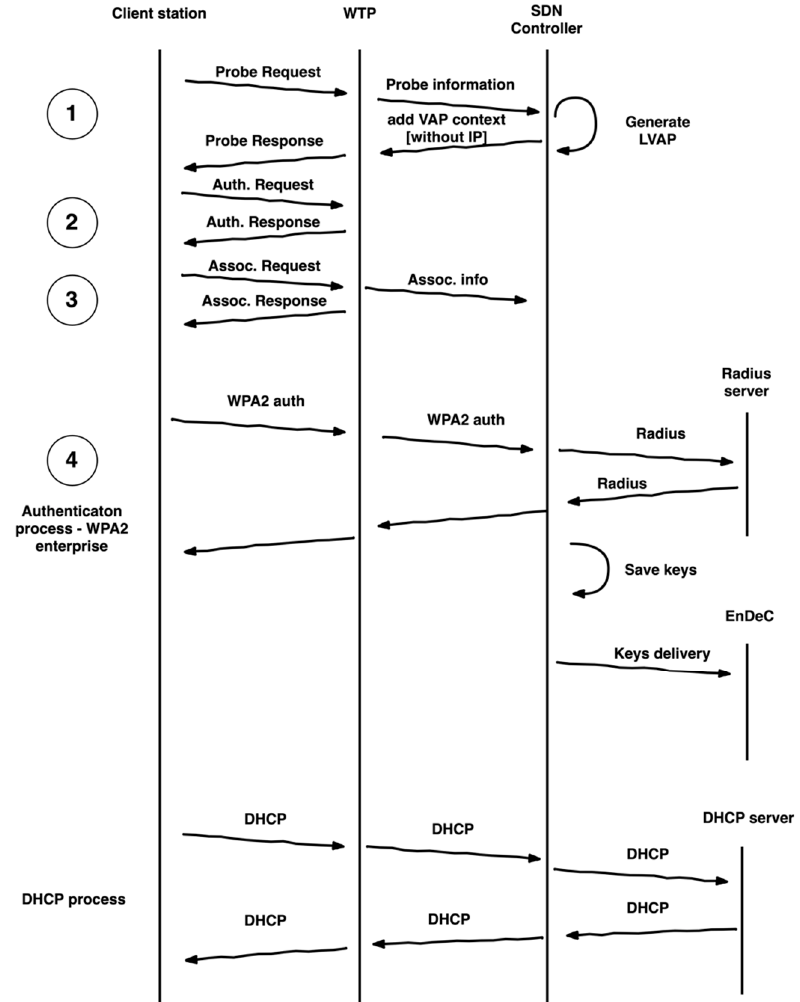
Figure 2. Association process flow.